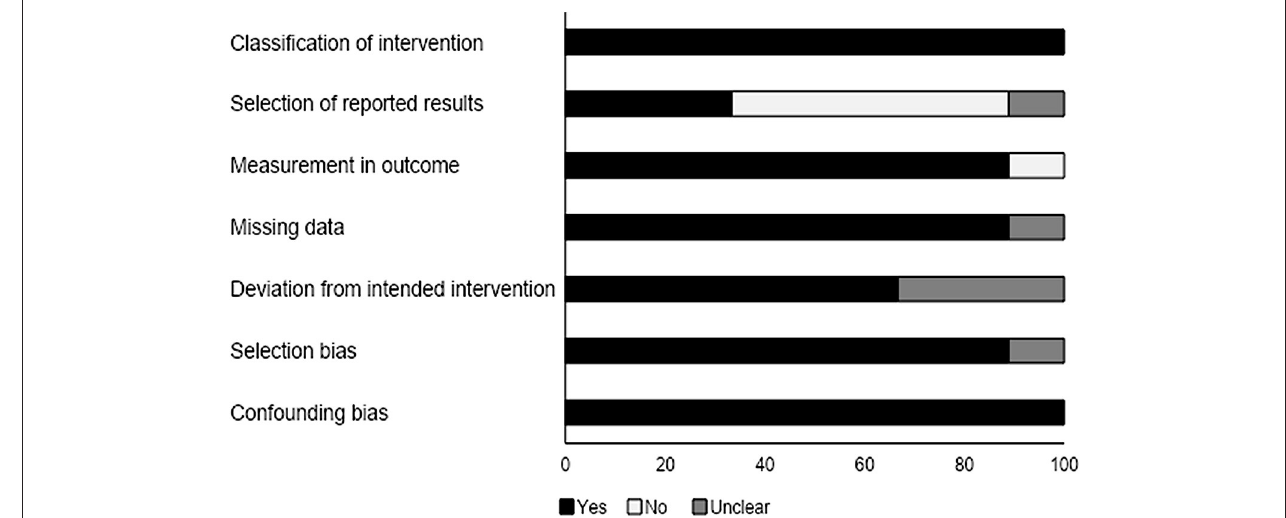
FIGURE 3 | Risk of bias according to the Cochrane risk of bias assessment for the non-randomized controlled trials.